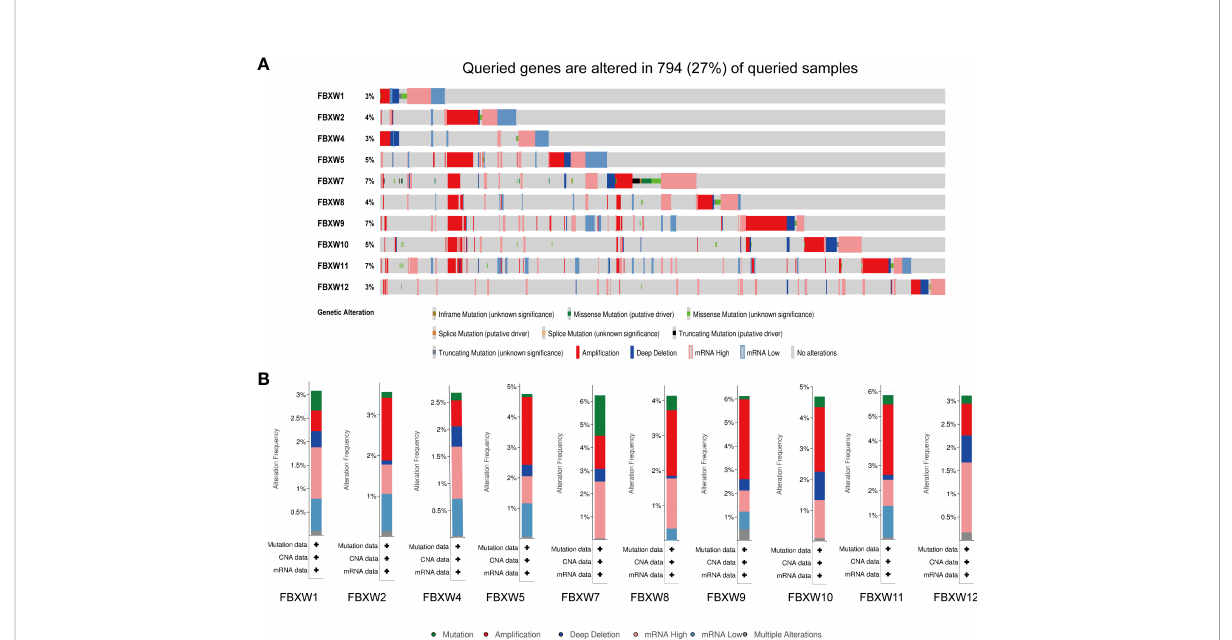
FIGURE 8 Genetic alterations and correlation analysis of FBXW family members in Pan-cancer. (A) summary of alteration rates for FBXW family from TCGA database using cBioPortal. (B) Genetic alteration frequency data of FBXW family members in pan-cancer, respectively.